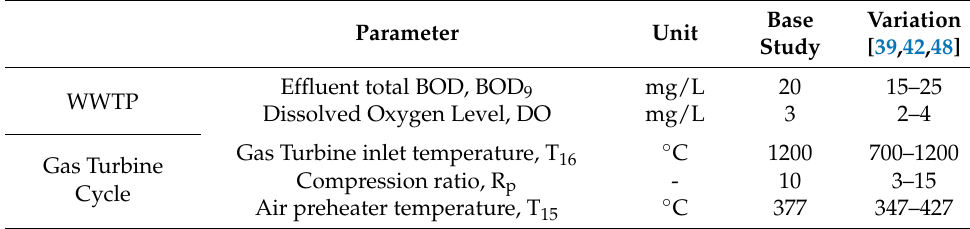
Table 7. Case Study Parameters and their variation in parametric study.